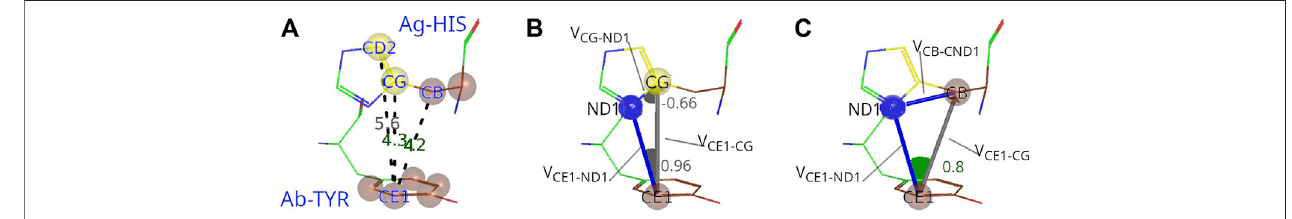
FIGURE 2 | Procedure to characterize C-C interactions between Ag and Ab. (A) The example of interacting carbon pair from PDB ID: 4CMH shows that the distances between CE1 atom from Tyr92 (paratope) and CB and CG atoms from His79 (epitope) are within the threshold (5 Å), but not between CE1 and CD2. (B) Evaluation of the potential shielding between CE1 and CG. The fi rst dot product between (cid:2) V CE 1 − CG and (cid:2) V CE 1 − ND 1 exceeds the threshold (0.85) and indicates that the ND1 atom from His79 is either between the C atoms, or behind CG. The second dot product between (cid:2) V CE 1 − CG and (cid:2) V CG − ND 1 con fi rms the shielding as its value is belowthethreshold ( − 0.2). (C) EvaluationofthepotentialshieldingbetweenCE1andCB.The fi rstdotproductvaluebetween (cid:2) V CG − CE 2 and (cid:2) V CG − ND 1 belowthethreshold (0.85) already proves that CE1-CB interaction is cleared. In all fi gures, carbon atoms accepted for the hydrophobic cluster are shown in brown, while rejected C atoms are in yellow and nitrogen in